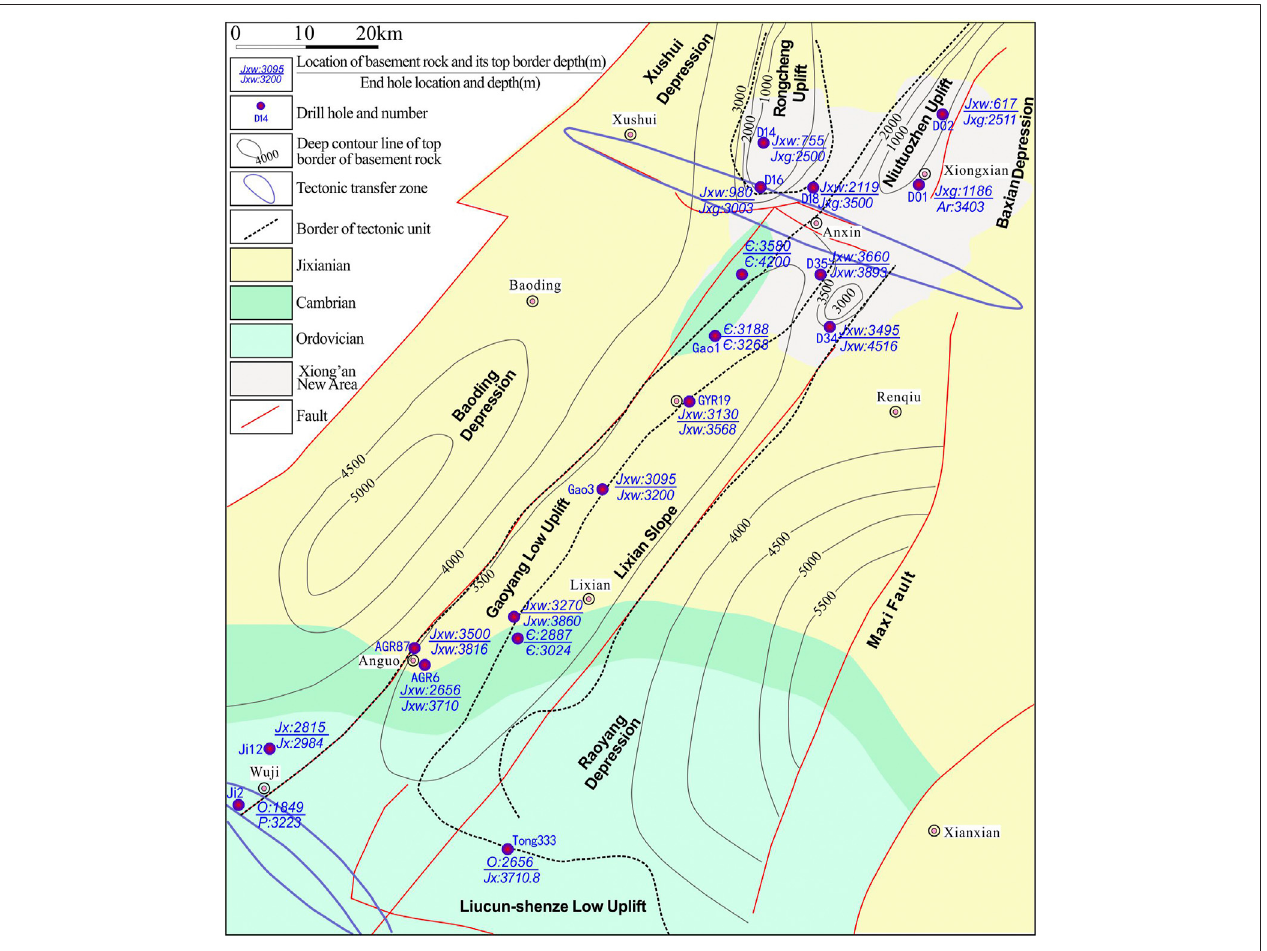
FIGURE 2 | Contour map of the buried depth of the top boundary of the Gaoyang geothermal fi eld and the surrounding bedrock heat reservoir.